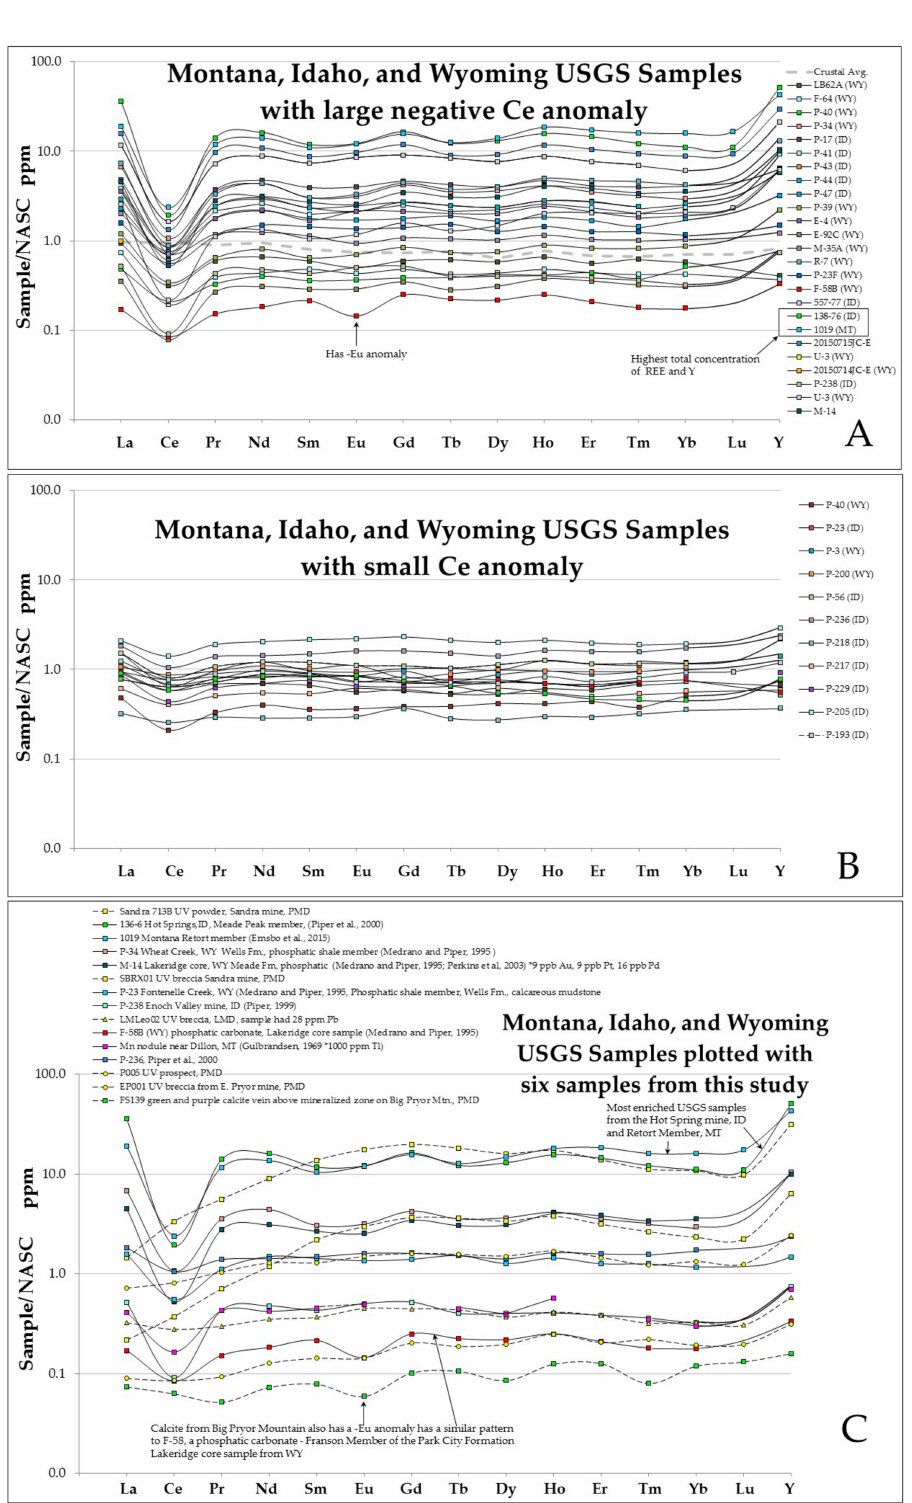
Figure 11. NASC-normalized REE and Y Permian Phosphoria Formation rock sample data ( A ) with strong negative Ce anomaly, slightly elevated Y; ( B ) with smaller negative Ce anomaly and flatter HREE and Y pattern; ( C ) Six samples from this study plotted with United States Geological Survey (USGS) samples. The most enriched PMD sample has similar, slightly higher concentration of REE and Y from Sm-Ho to the most enriched USGS sample. The only PMD sample with a negative Eu anomaly is similar to a phosphatic carbonate from the USGS Lakeridge core, WY that also has a negative Eu